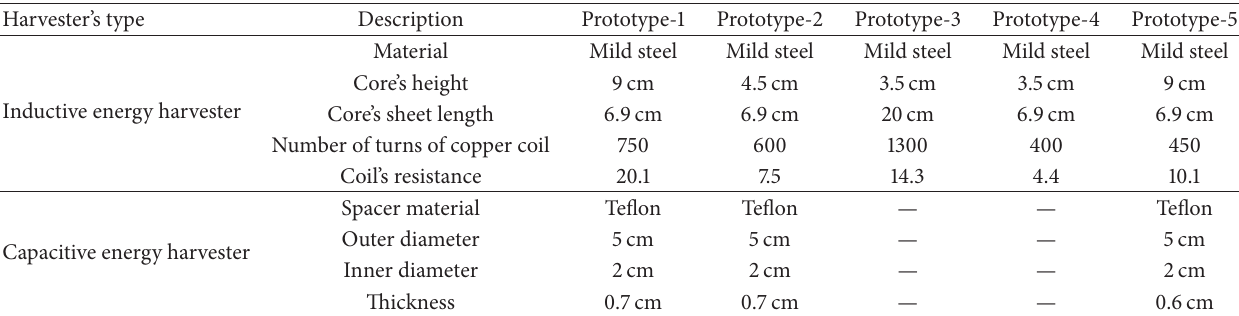
Figure 12: Fabrication of prototype-3 and prototype-4: (a) multiturn inductive core of prototype-3, (b) Teflon split housing hinged, (c) end plates and locking mechanism attached to the split cylinder, (d) wounded steel plate wrapped over a power cable to produce the inductive energy harvester, and (e) inductive energy harvester placed in the split housing prototype-4. Table 2: Dimension and parameters of developed energy harvester